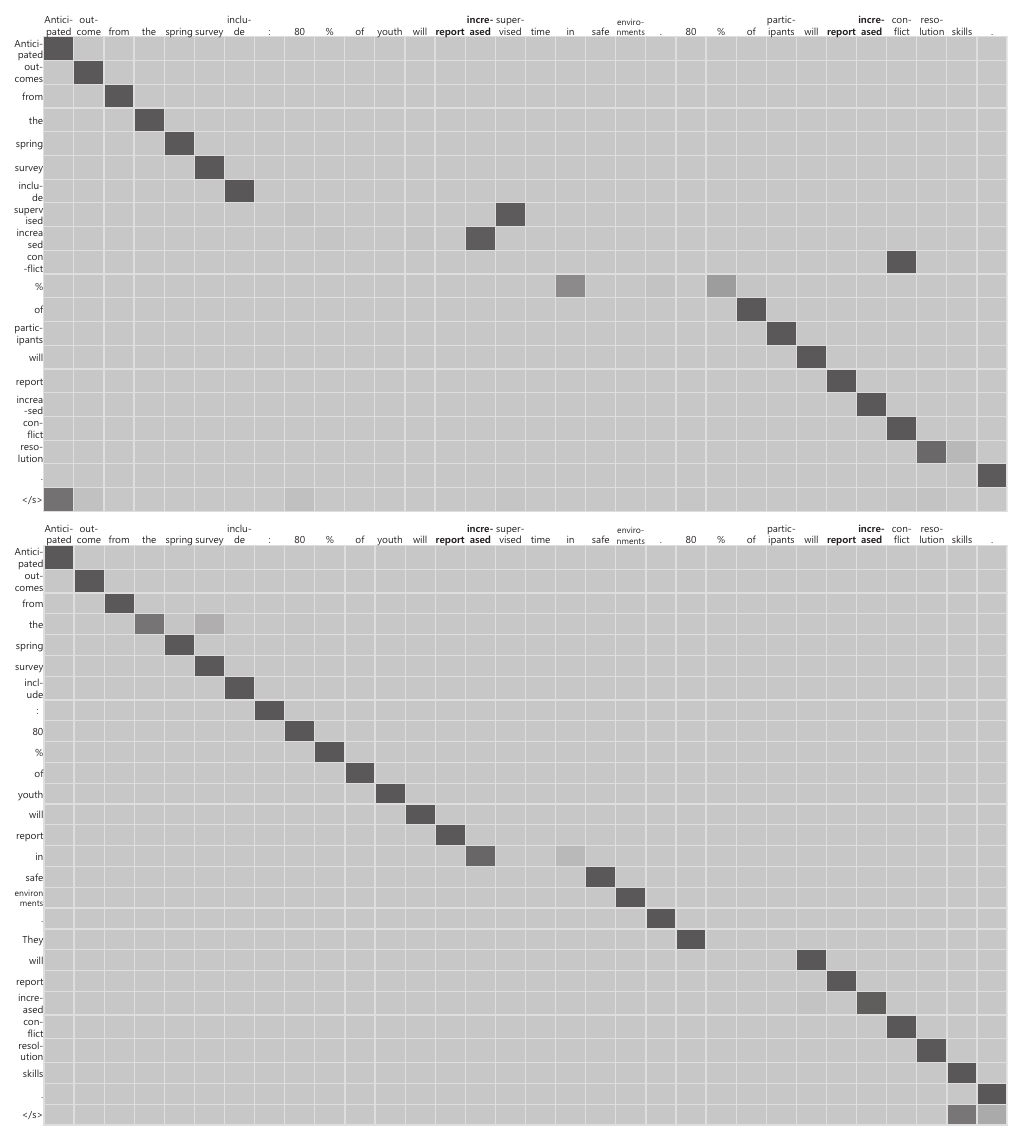
Figure 2. The attention weights on Sentence 1 in Table